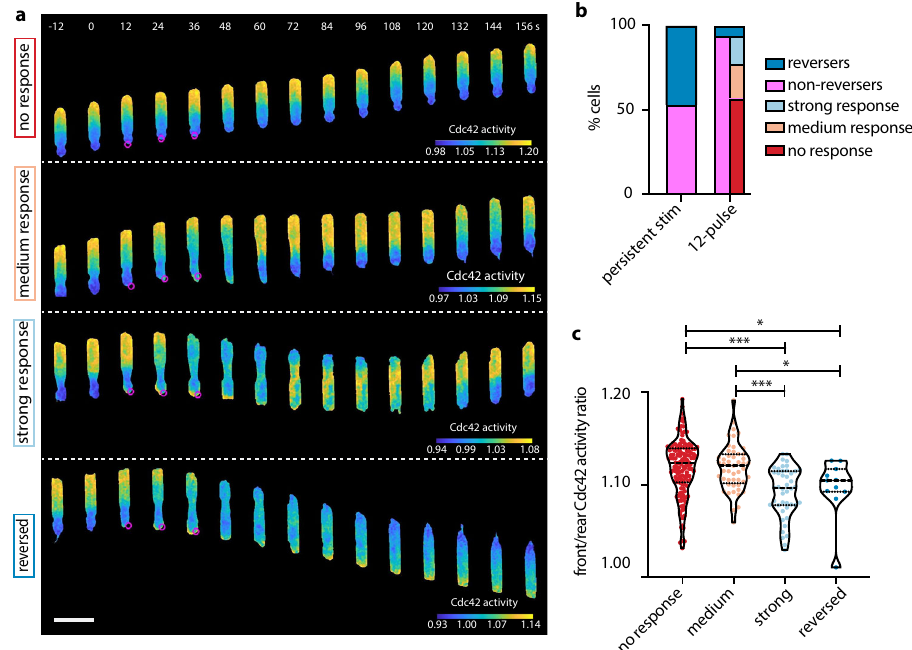
Fig. 3 Transient stimulation reveals a variety of distinct cellular responses. a Representative live-cell imaging snapshots of stimulation experiments with cells expressing parapinopsin and a red/far-red Cdc42 FRET sensor, showing no response (upper panel), medium response, strong response, and a reversed response (lower panel). Cells migrated unperturbed for 60 s prior to starting a transient 12-pulse stimulation at their cell rear (magenta circles). Images were captured every 3 s and subsampled for illustration purposes. Scale bar: 25 μ m. b Stacked bar plot of the percentage of cells that exhibited each cellular response with persistent pulsated stimulation ( n = 336 cells from 36 independent experiments) and with transient 12-pulse stimulation ( n = 261 cells from 20 independent experiments). c Violin plot of mean front/rear Cdc42 activity ratio of n = 141 non-responders, n = 49 medium responders, n = 44 strong responders, and n = 11 reversers, averaging over 15 s prior to stimulation; p -values of two-sided Wilcoxon ’ s rank-sum test (* p < 0.05, *** p < 0.001, pairs not shown have p > 0.05). Source data are provided as a Source Data fi le, including exact p